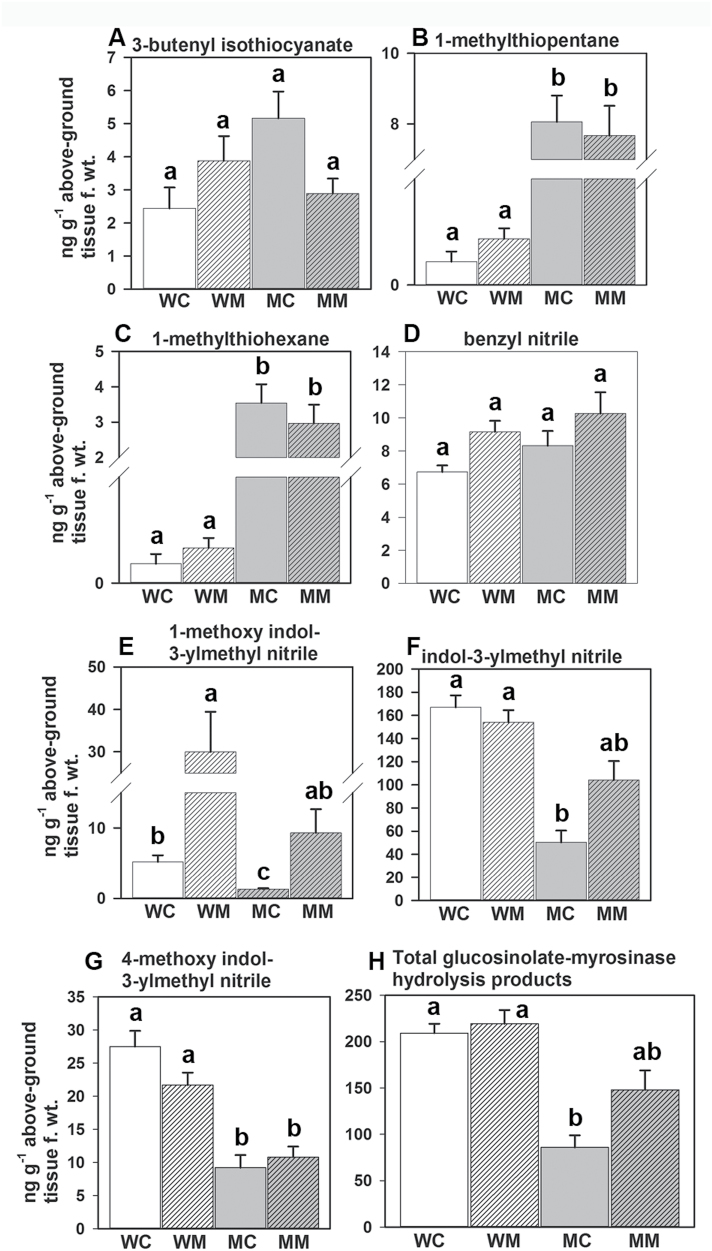
Glucosinolate–myrosinase hydrolysis product levels in control and M. brassicae-challenged seedlings (n = 6). Different letters above the bars indicate significant differences for 3-butenyl isothiocyanate (3BITC), 1-methyl thiopentane (1MTPe), 1-methyl thiohexane (1MTHx), benzyl nitrile (BNIT), 1-methoxy indole-3yl-methylnitrile (1MI3M NIT), indole-3yl-methylnitrile (I3M NIT), 4-methoxy indole-3yl-methylnitrile (4MI3M NIT), and total glucosinolate hydrolysis products levels (Kruskal-Wallis test followed by pairwise Wilcoxon Mann-Whitney tests and Bonferroni post hoc testing, P < 0.00833). Error bars represent the SE. WC, wild-type control; MC, MINELESS control; WM, wild-type M. brassicae; MM, MINELESS M. brassicae.